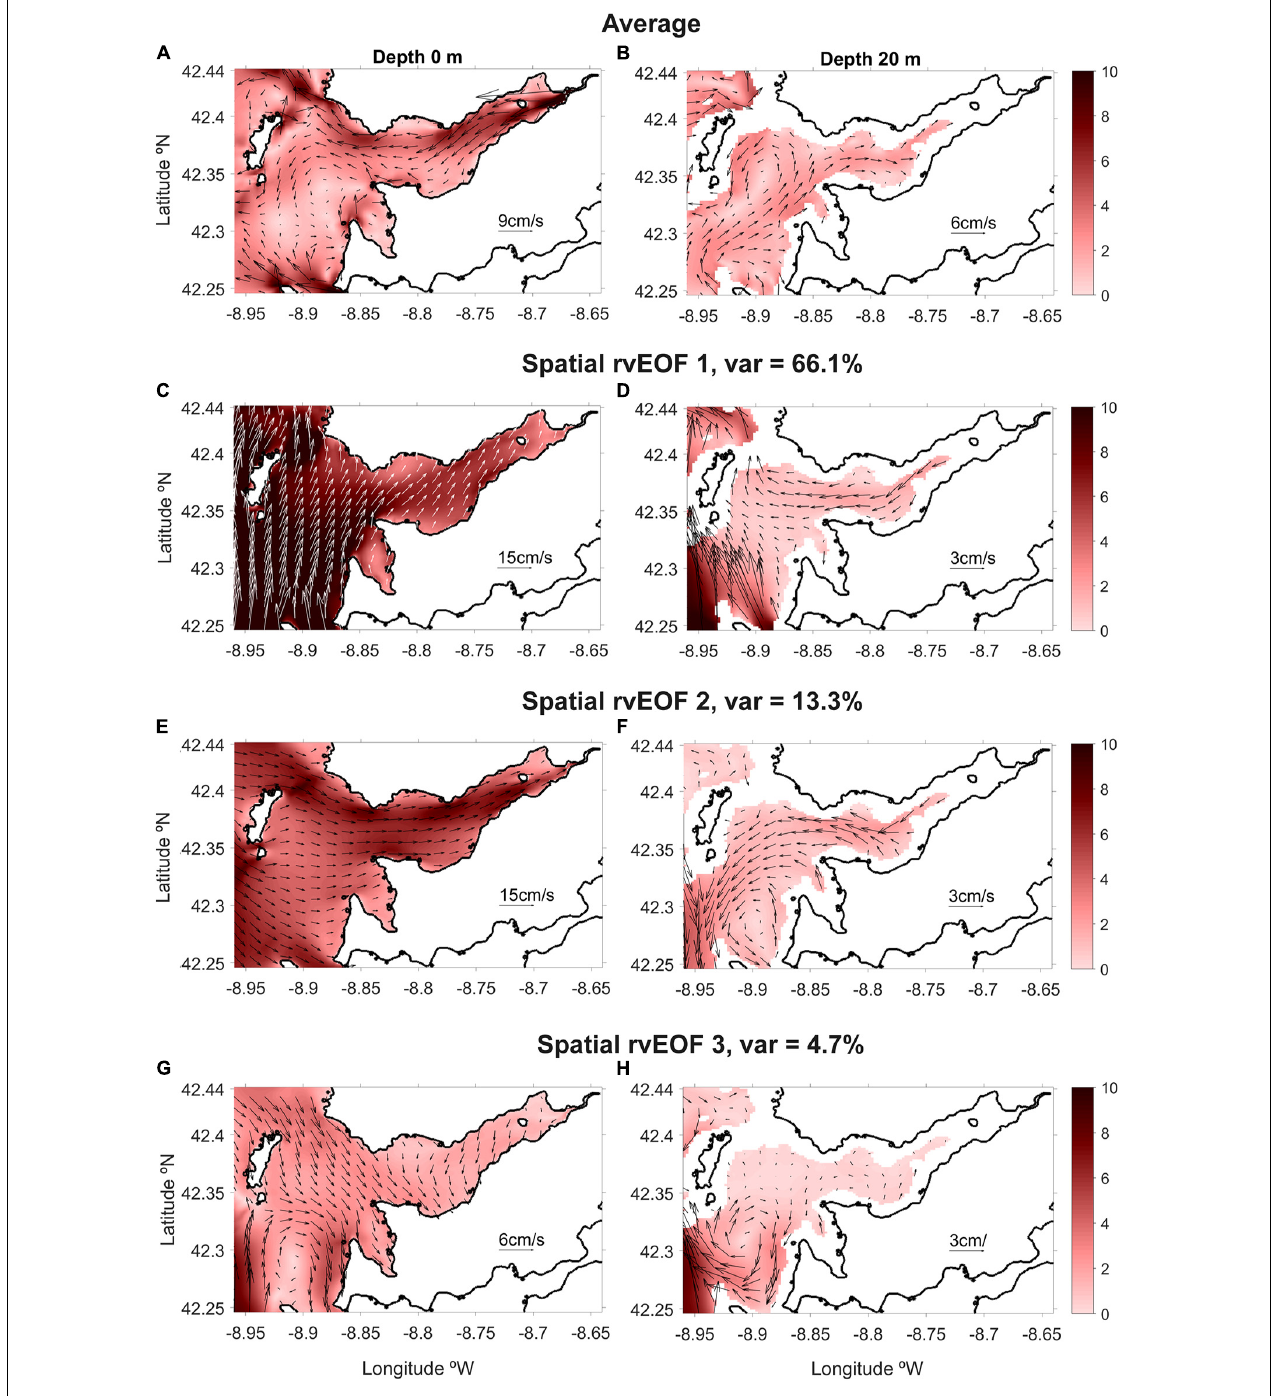
FIGURE 9 | Spatial Real-vector EOF (rvEOF) of the meridional (V) and zonal (U) subtidal components of velocity at 0 and 20 m depths. (A,B) Average velocity for 2015 at the surface (z = 0) and at z = − 20 m. Spatial rvEOF of (C,D) mode 1, (E,F) mode 2 and (G,H) mode 3. The velocity scales are depicted inside every graphic. The colorbar represents the module of the